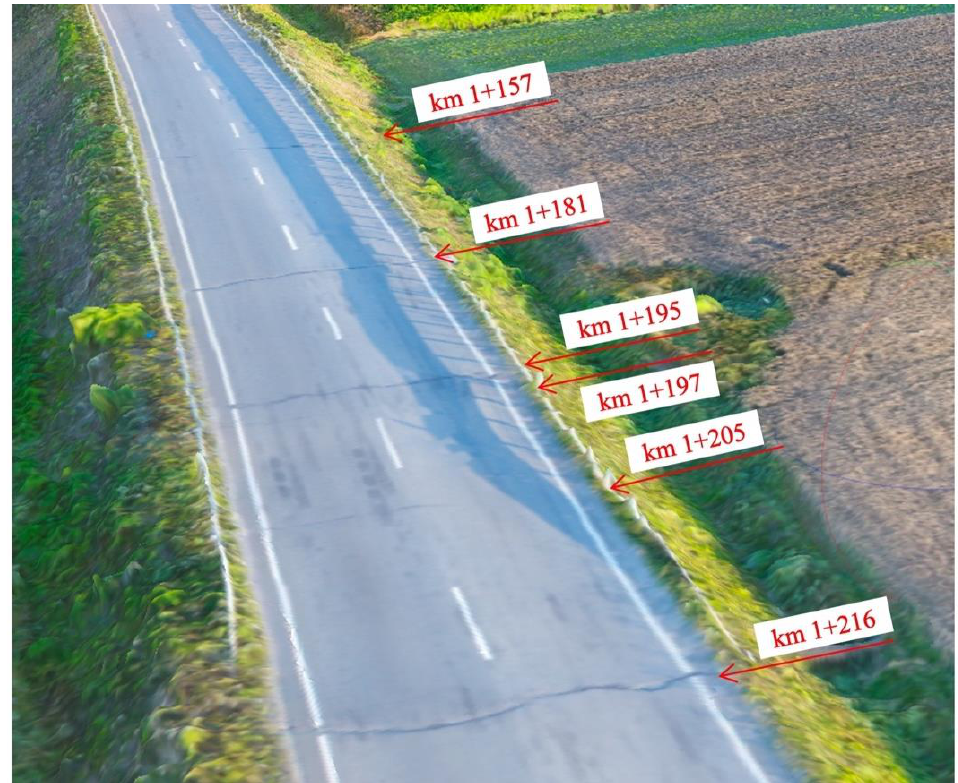
Figure 5. Location of pavement damage in the zone of linear discontinuous deformations occurring in 2021.